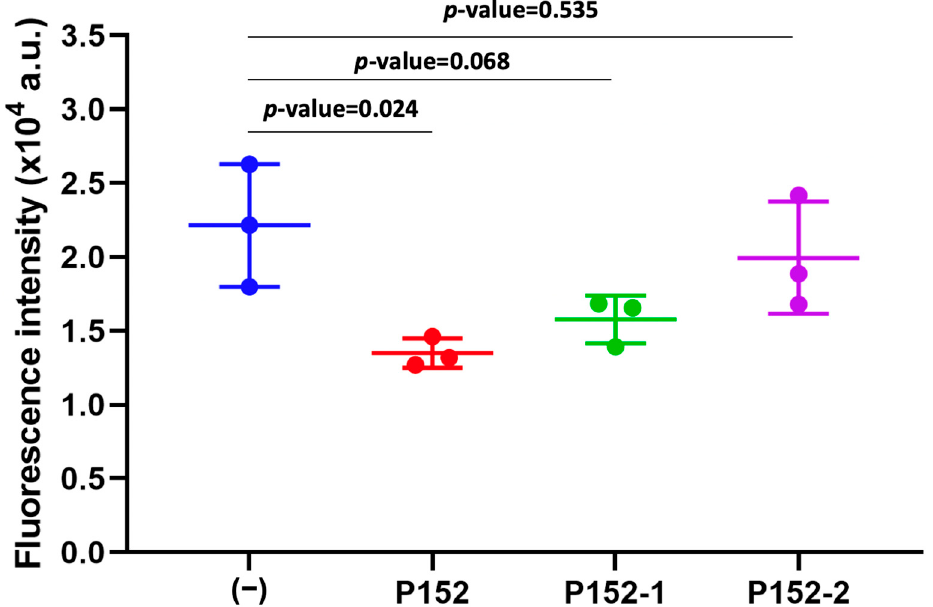
Figure 5. Comparison of the anti-migration activity of P152 to its scrambled sequences. MDA-MB- 231 cells were treated with P152 (CFMKRLRK), P152-1 (FRKCKMRL) or P152-2 (KKRCRFLM), at a concentration of 100 nM in the Boyden chamber assay. ( − ), no treatment. Error bars show SD (n = 3). p -value was calculated by a t -test.